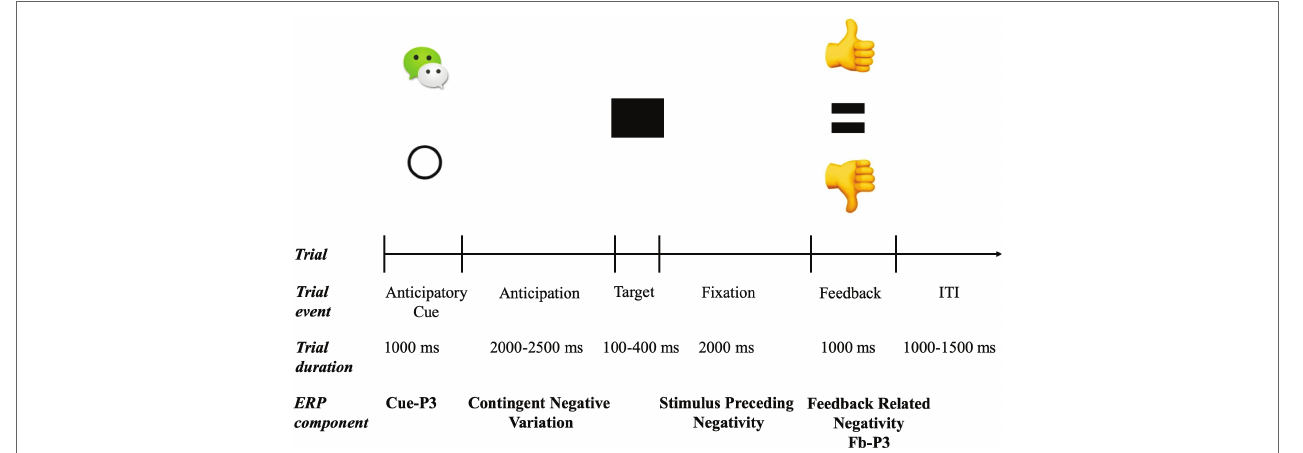
FIGURE 1 | Trial structure and related ERP components for social incentive delay tasks. On each trial, one of two possible cues was presented: social incentive (WeChat logo) or neutral (empty circle). Target duration began at 250 ms and was dynamically adjusted based on task performance. On social incentive trials, win and loss feedbacks (i.e., thumbs-up or thumbs-down) were uncertain and based on performance; on neutral trials, feedback (i.e., “=”) was certain and